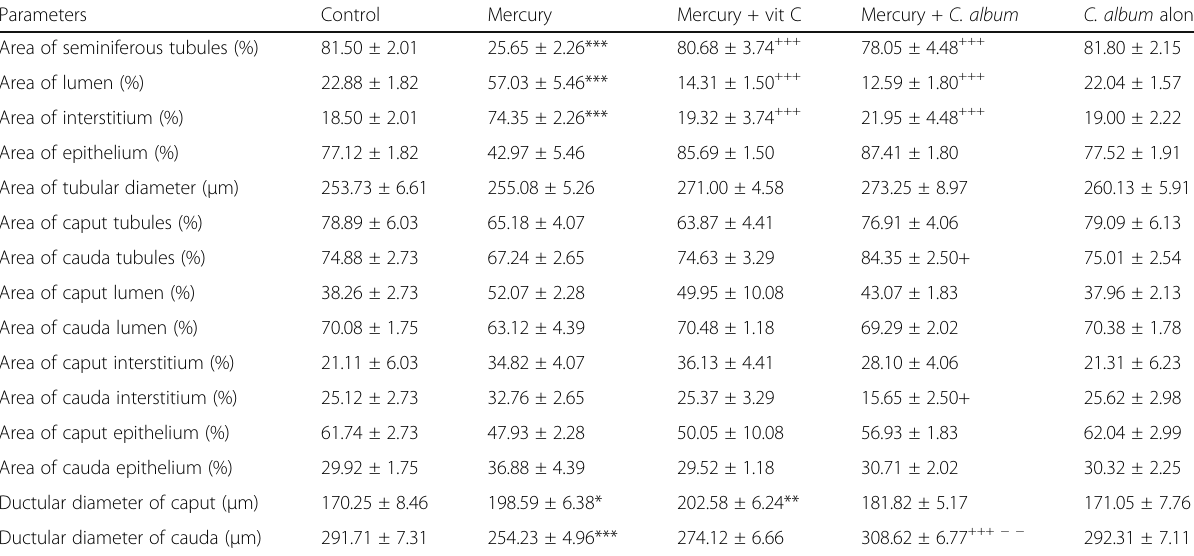
Table 5 Effect of C. album extract and vitamin C treatment on testicular morphometric parameters in different experimental groups